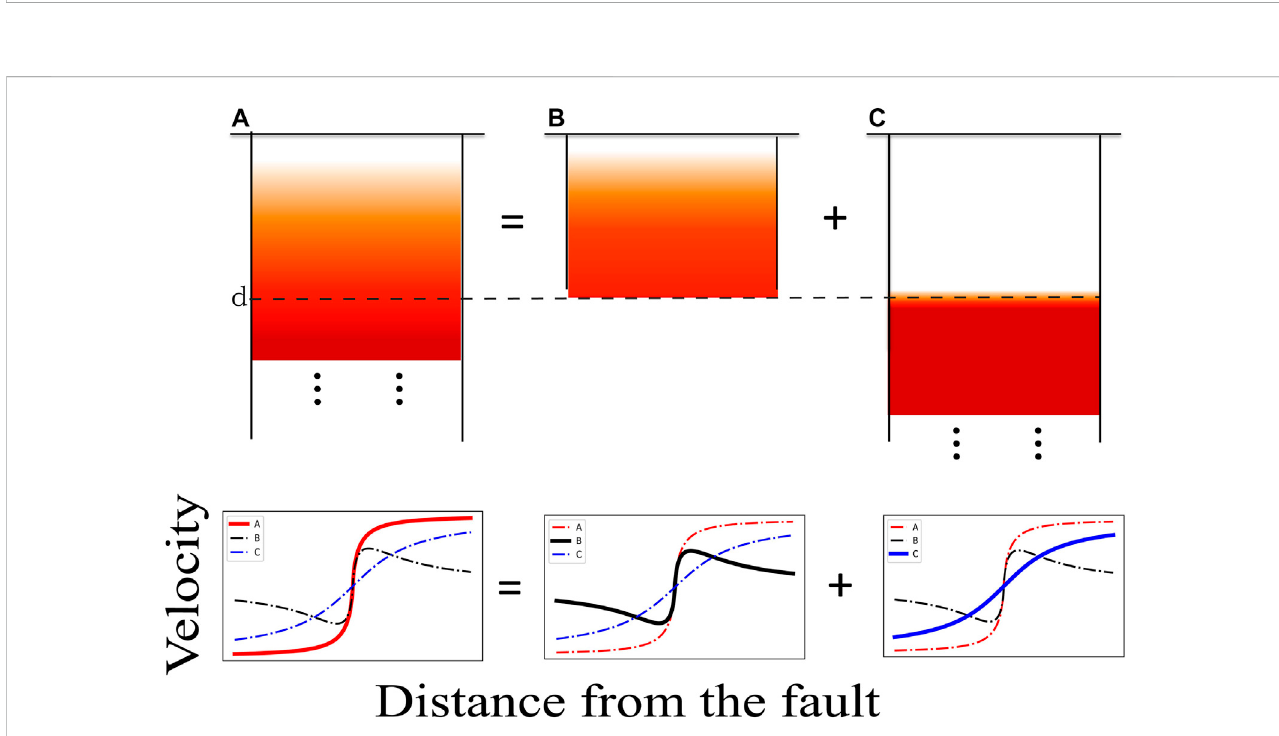
FIGURE 7 Schematicofthesuperpositionofthedecoupledfraction,whichincreaseswithdepth;faultA=faultB+faultC.Thecorrespondingdeformationsatis fi es the equation. Red, black, and blue lines represent the deformation of faults (A, B, and C,) respectively.